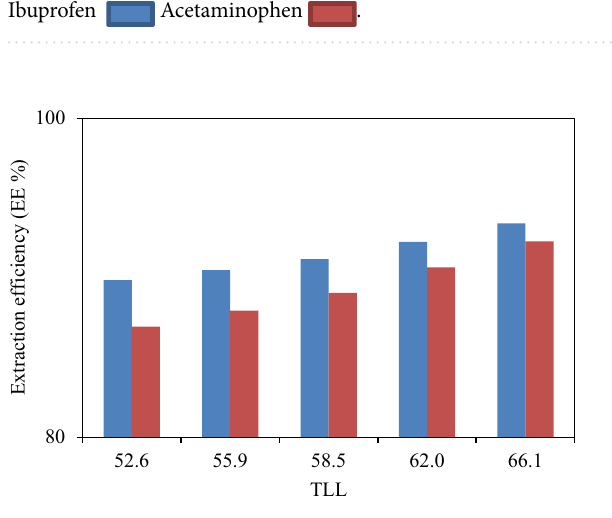
Figure 3. Extraction efficiency, EE %, in function of the TLL for each studied drug in ATPS {KOH + PEG 600 + H 2 O}. Ibuprofen Acetaminophen